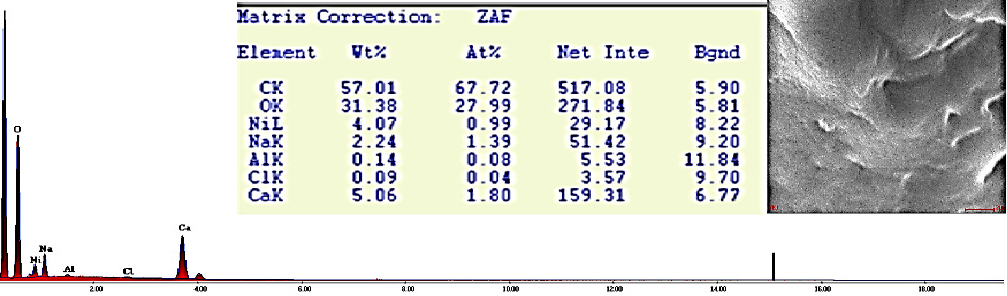
Figure 6. SEM images of CA–SCGs beads: ( a ) before adsorption; ( b ) after adsorption at 100 ppm Cd 2+ and ( c ) after adsorption at 100 ppm Ni 2+ .